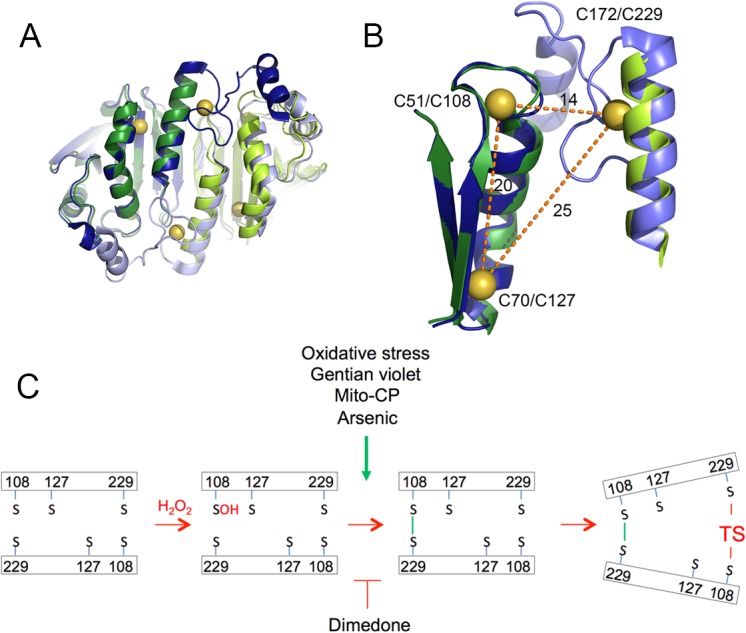
A catalytic intermediate of PRX3 is a molecular target of thiostrepton.(A) Superposition of human Prx2 and bovine Prx3. The monomers of the Prx2 and Prx3 dimer are shown in blue/light blue and green/light green, respectively. The sulfur atoms of the Cys residues are shown as spheres. (B) Proximity of Cys residues. All Cys residues are conserved. The residue numbers indicated are for human Prx2/Prx3. Distances shown are in Angstroms. PDB codes 1QMV and 1ZYE. Note that the C-terminus of Prx3 is disordered and not shown. (C) Model for TS adduction of Prx3. During the PRX3 reaction cycle the formation of a disulfide bond at one catalytic dyad promotes local unfolding. We propose that this conformation change favors adduction of Cys108 and Cys229 in the neighboring catalytic center by TS, leading to an irreducible, crosslinked PRX3 dimer and loss of peroxidase activity. Pro-oxidant compounds such as gentian violet, Mito-CP or arsenic trioxide and oxidative stress increase the level of PRX3 disulfide-bonded dimers and promote adduction by TS. Dimedone attacks sulfenic acid moieties and blocks disulfide formation, thereby blocking modification of PRX3. Similarly, mutant forms of PRX3 lacking the peroxidatic or resolving cysteines are not targets of TS.